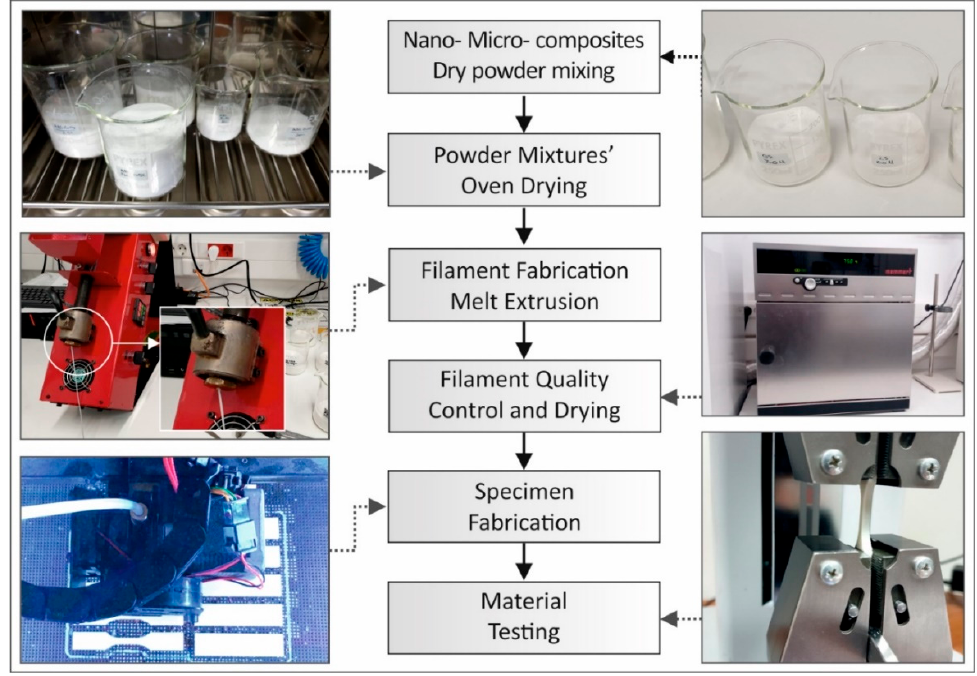
Figure 1. Nano- and micro-composite filaments’ and specimens’ fabrication methodology.